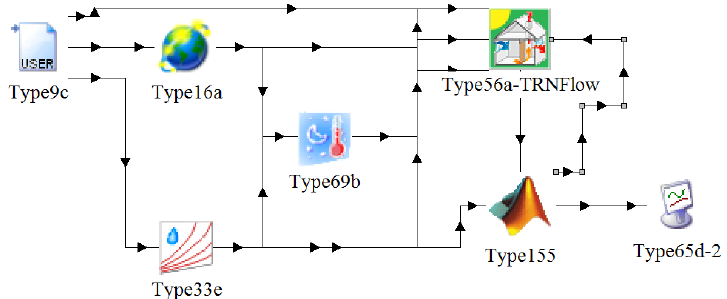
Figure 7. Composition of the simulation